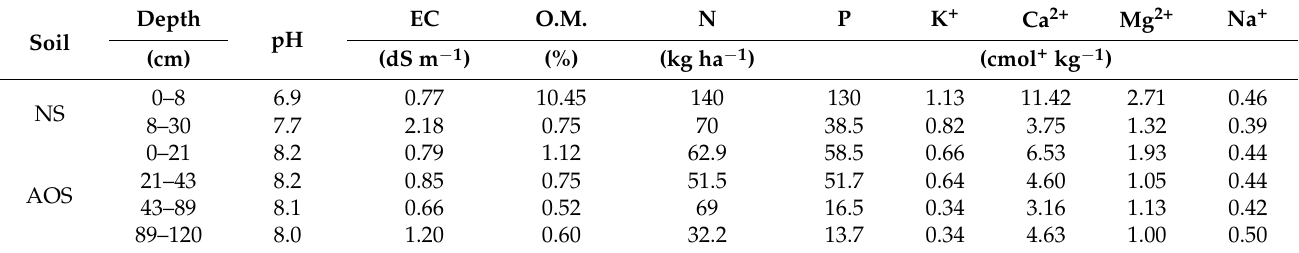
Table 4. Chemical analysis of the natural soil and agriculture organic soil profiles